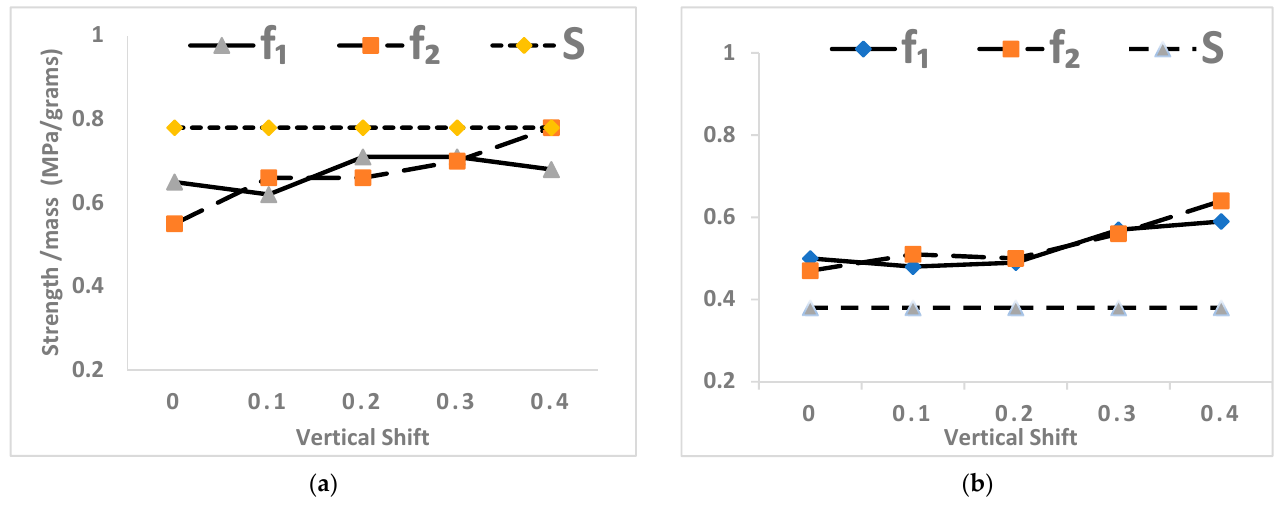
Figure 10. Graphical representation of the relationship between strength to mass ratio versus vertical shift ( a ) with 100% infill density ( b ) with 70% infill density.